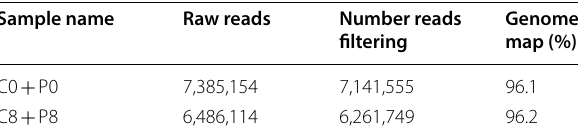
Sequencing and mapping parameters of the C0 plus P0 and C8 plus P8 genome